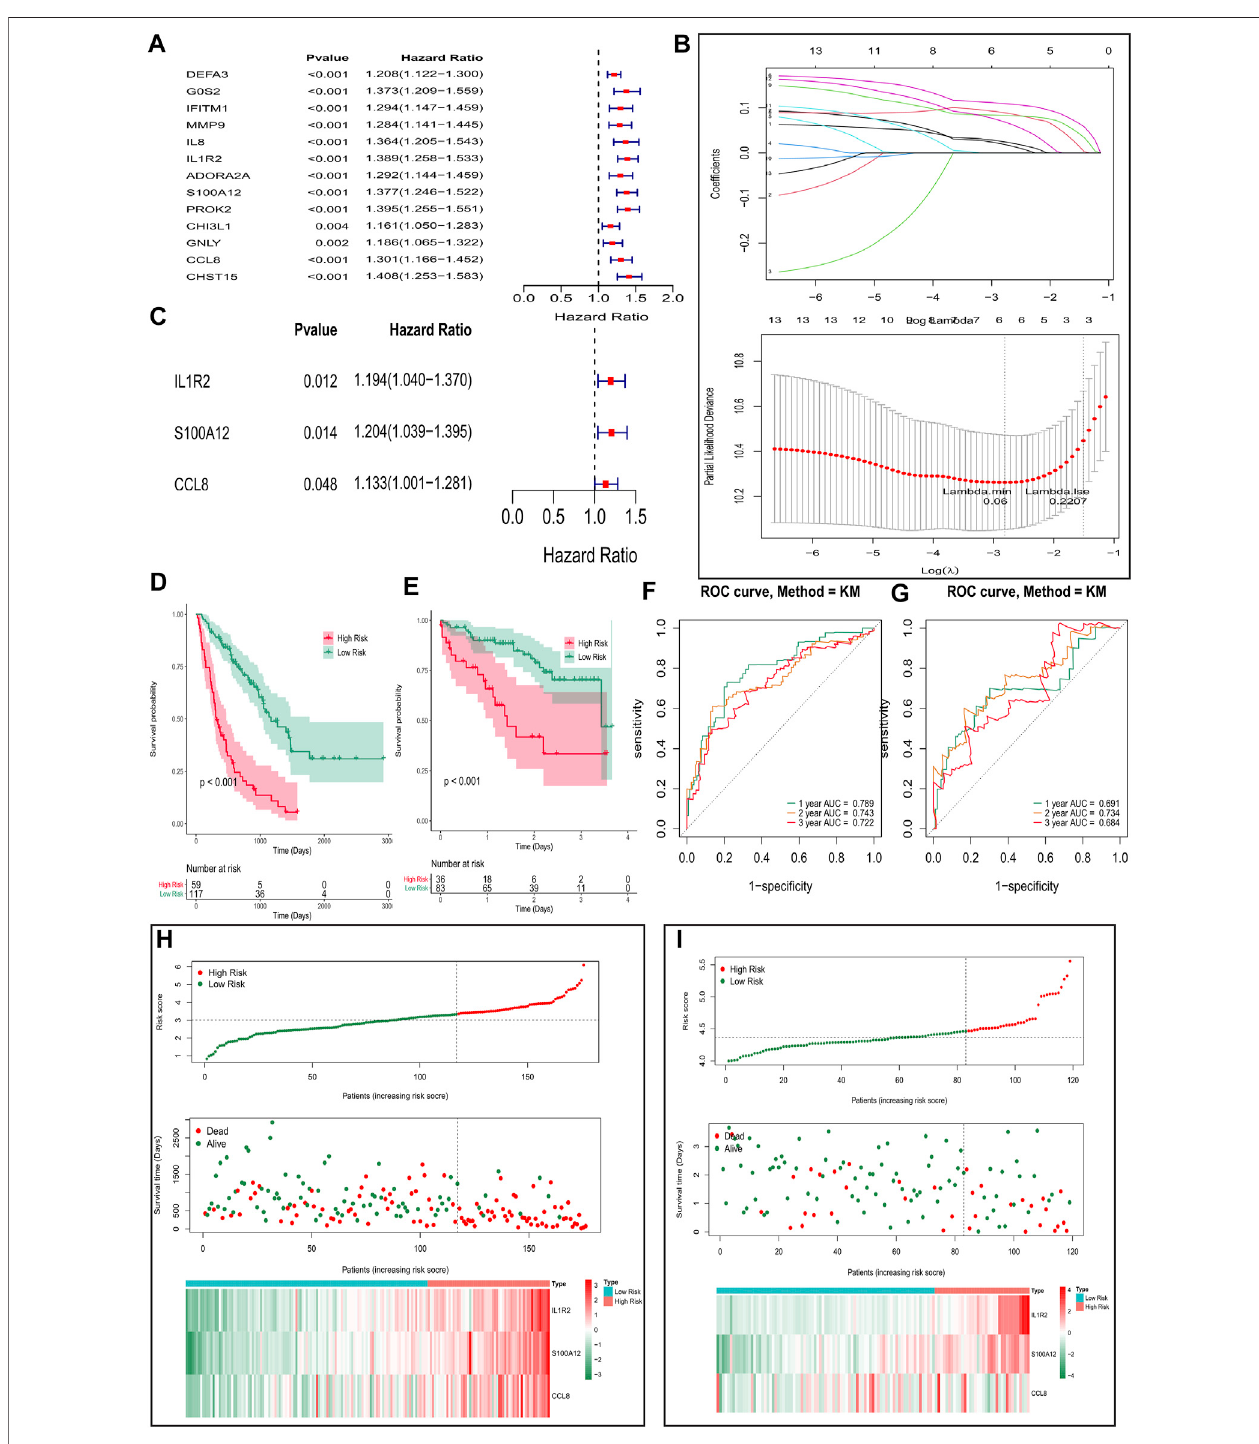
FIGURE 5 | Construction and validation of the EMT- and immune-related gene signatures based on EMT- and immune-related genes. (A) Univariate Cox regression analysis identi fi ed genes related to the prognosis of IPF patients in the training set. (B) Screening of characteristic genes by LASSO regression analysis. (C) MultivariateCoxregressionanalysistoconstructtheEMT-andimmune-relatedgenesignaturesinthetrainingset. (D,E) Survivalcurveofhigh-andlow-riskgroupsinthe training set (D) and validation set (E) . (F,G) ROC curves evaluated the ef fi ciency of the risk signature for predicting 1-, 2-, and 3-year survival in the training set (F) and the validation set (G) . (H,I) Three genes expression pro fi les, the risk score distribution, and patients ’ survival status in the training set (H) and the validation set (I) .